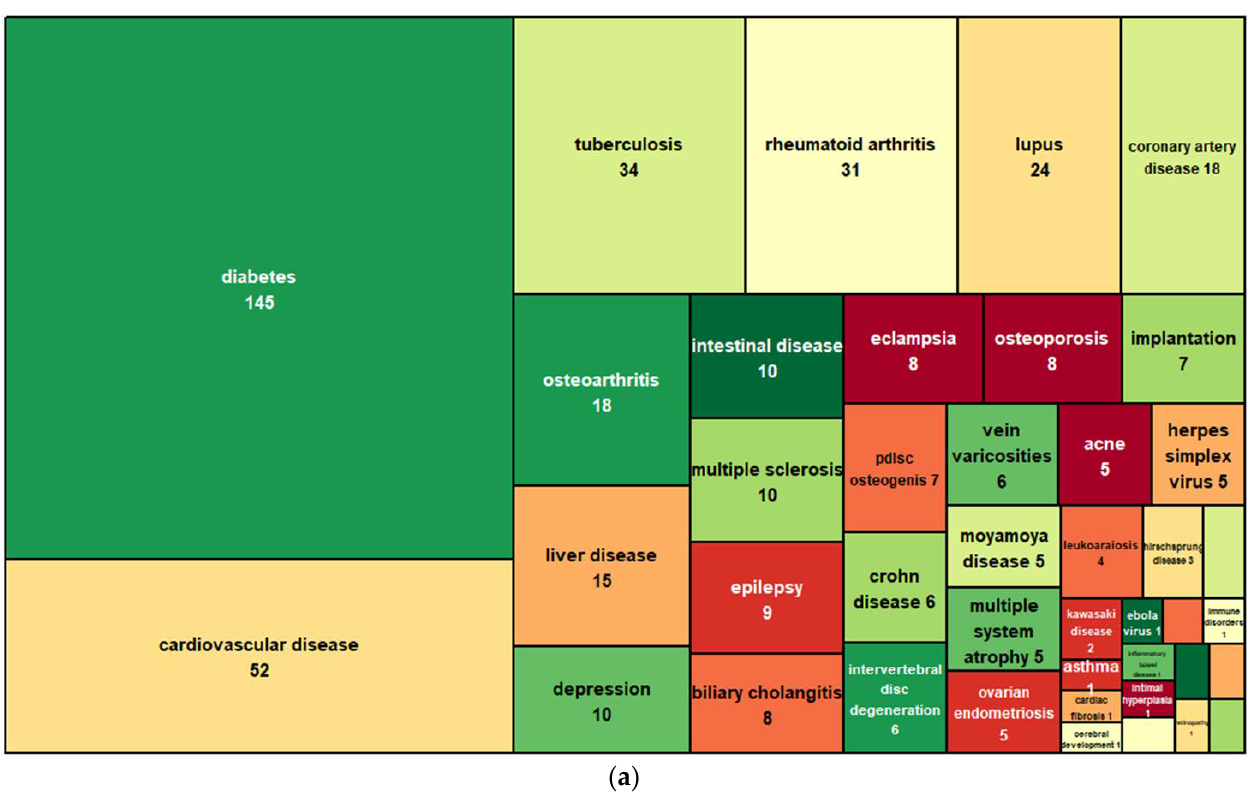
Figure 1. Structural categories of circRNAs. ( A ) Exonic circRNAs consist of only exons. ( B ) Intronic circRNAs consist of only introns. ( C ) Sense-overlapping circRNAs consist of exons and introns. ( D ) Antisense circRNAs are in strand direction antisense to their linear RNA counterparts. The exon numbers are for illustration only.